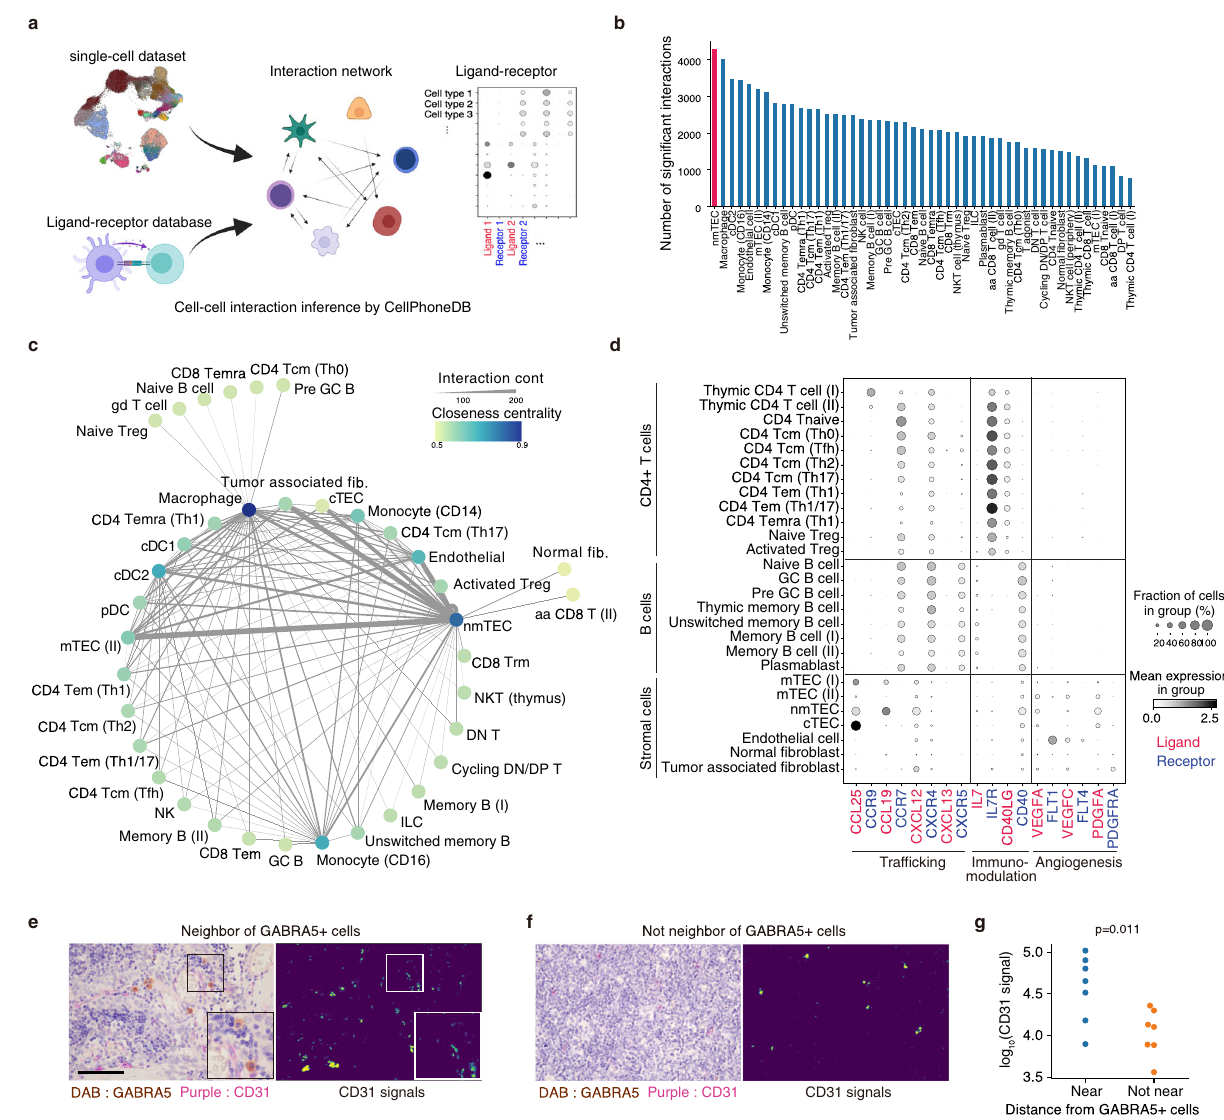
Fig. 5 nmTECs strongly associated with epithelial cells, myeloid cells, and T cells with characteristic ligand-receptor pairs. a Schematic view of the cell – cell interaction analysis. b Bar chart showing the number of signi fi cant interactions with other cell types in each cell type. c Cell – cell interaction network inferred from scRNAseq data. Each node represents a cell type, and the thickness of each edge represents the number of signi fi cant interactions. Edges with <75 signi fi cant interactions were removed. d Dot plot of gene expression of ligand-receptor pairs involved in traf fi cking, immunomodulation, and angiogenesis in CD4 + T cells, B cells, and stromal cells. e , f Representative images of the colocalization of nmTECs (GABRA5; DAB) and endothelial cells (CD31; purple) in the vicinity of GABRA5 + cells ( e ) and not in the vicinity of GABRA5 + cells ( f ). Binarized signals are shown in yellow. Scale bar: 100 µ m. g Protein levels of CD31 near and not near from GABRA5 + cells in MG-thymoma quanti fi ed using microscopic images (Near n = 7, Non-Near n = 7. Details are provided in Supplementary Fig. 13 and Methods. Source data are also provided as a Source Data fi le.). For each group, seven areas from four MG patients were quanti fi ed. The signals were analyzed using a two-sided Mann – Whitney U -test.